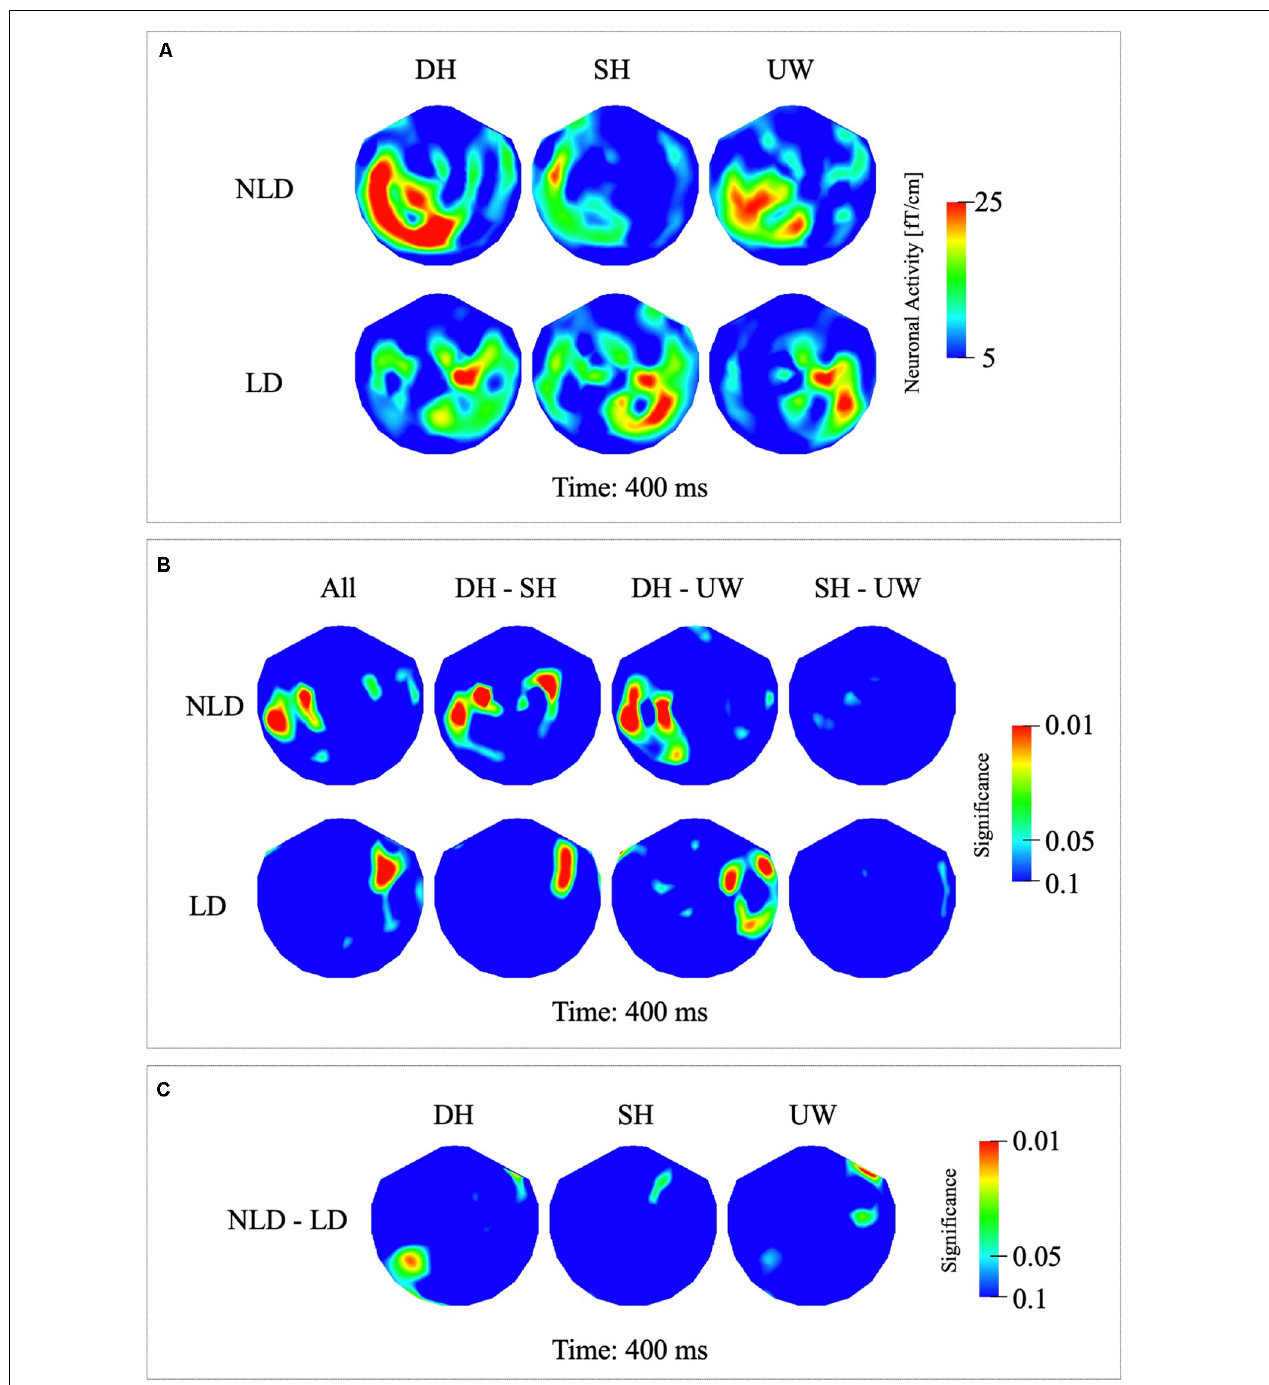
FIGURE 5 | (A) First row: Local RMS-maps for the NLD group’s responses to final words (dominant homonym, subordinate homonym, and unambiguous word) at 400 ms. Second row: Local RMS-maps for the LD group’s responses to final words (dominant homonym, subordinate homonym, and unambiguous word) at 400 ms. (B) First row: NLD group’s Friedman analysis result for dominant homonym, subordinate homonym, and unambiguous word at 400 ms. Wilcoxon pairwise analysis result of dominant homonym and subordinate homonym, dominant homonym and unambiguous word, and subordinate homonym and unambiguous word at 400 ms. Second row: LD group’s Friedman analysis result for dominant homonym, subordinate homonym, and unambiguous word at 400 ms. Wilcoxon pairwise analysis result of dominant homonym and subordinate homonym, dominant homonym and unambiguous word, and subordinate homonym and unambiguous word at 400 ms. (C) Mann–Whitney U analysis result for NLD vs. LD groups’ responses to final words (dominant homonym, subordinate homonym, and unambiguous word) at 400 ms. For the presentation of data, the detectors have been projected into two dimensions (right ear on the right, front at the top).